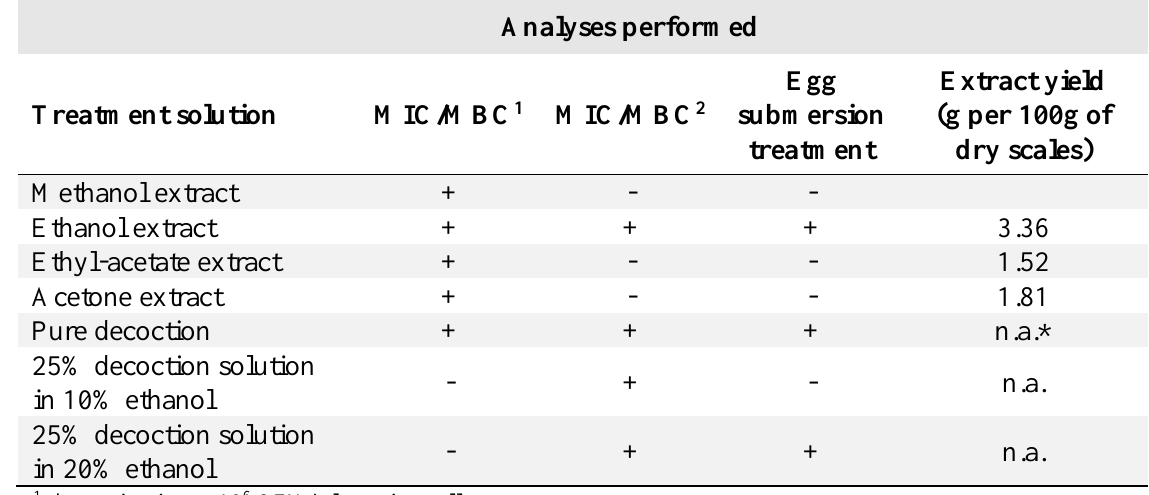
Table 1. Overview of onion ( Allium cepa ) dry scale treatment solutions used in experiments. Analyses